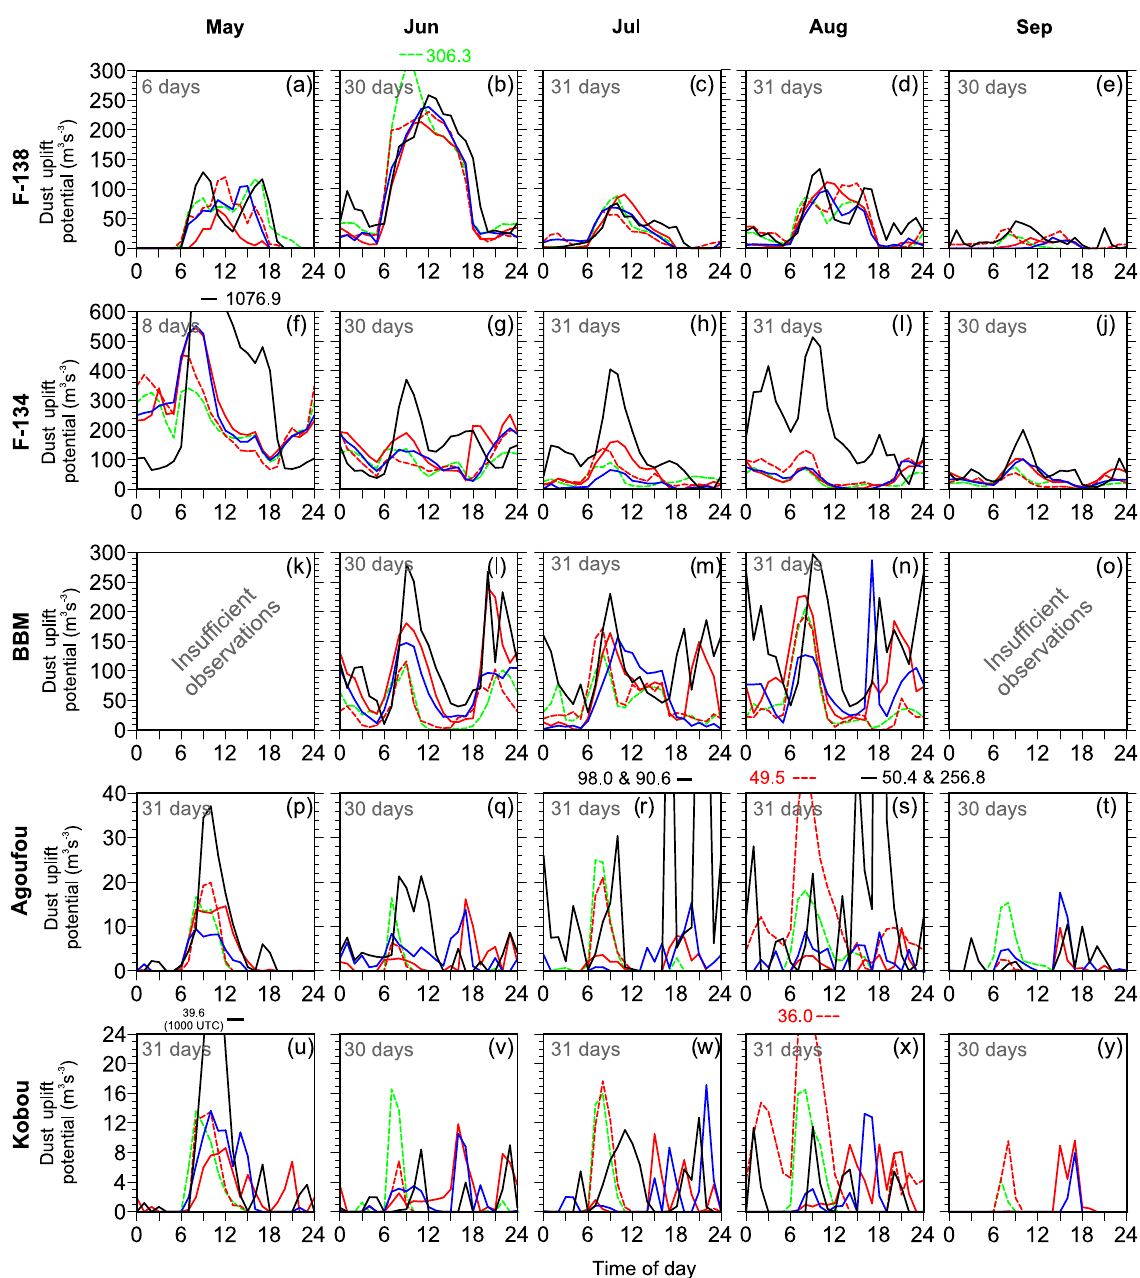
Figure 9. Diurnal cycle of dust uplift potential at the five observation stations for all 5 simulated months. Colours and dashed lines are the same as Fig. 7 (black is observations, green is 40km simulation, red is 12km simulations and blue is 4km simulation, dashed lines indicate parameterisation of convection and solid lines indicate explicit convection). Where fewer than 5 days with data were available the diurnal cycle has not been calculated. For clarity the number of days with data has been shown for each